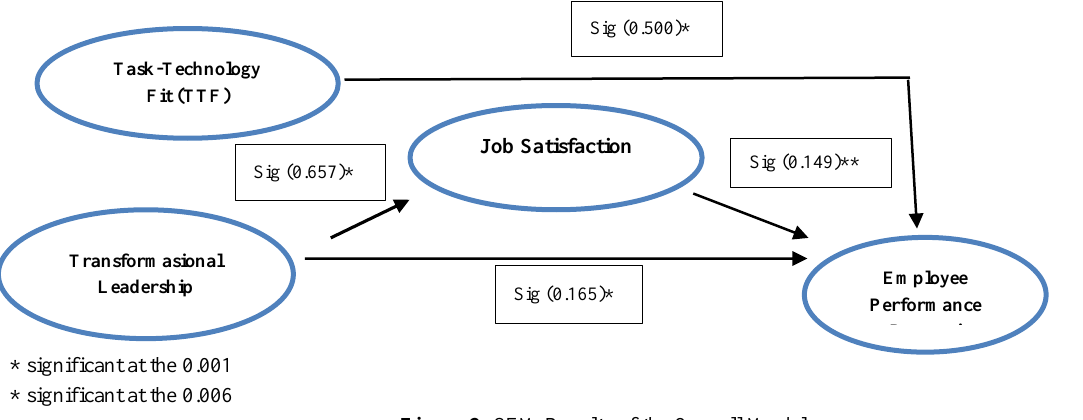
Figure 2: SEM Results of the Overall